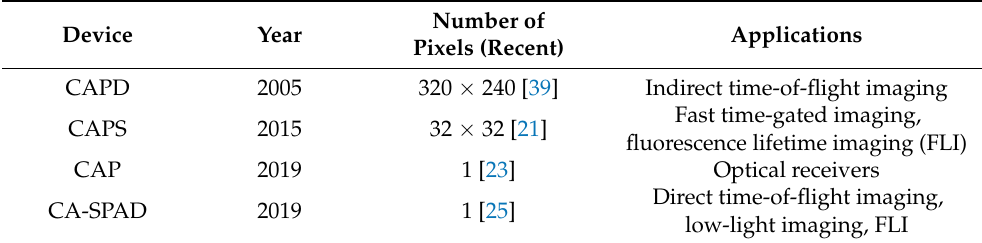
Table 5. Summary of current-assisted